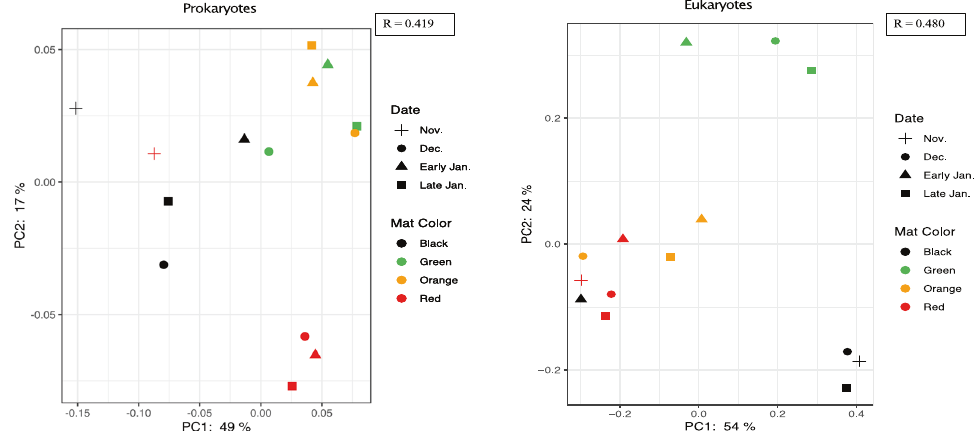
Fig. 4 Principal coordinate analyses (PCoA). UniFrac weighted distance matrices with ANOSIM values generated from (left)16S rRNA and (right) 18S rRNA ASVs. Shapes of plotted points denote sample collection date and colors denote mat type of